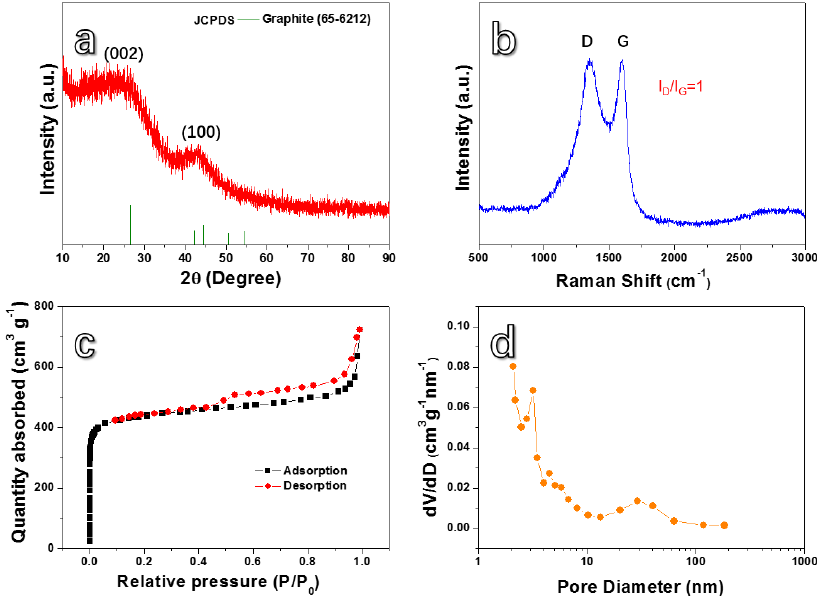
Figure 2. ( a ) X-ray diffraction (XRD) pattern, ( b ) Raman spectrum, ( c ) N 2 adsorption-desorption isotherm characteristics, and ( d ) pore size distribution of the HPC.